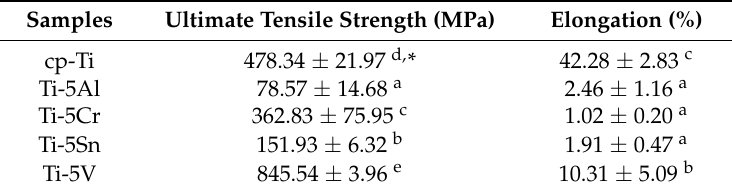
Table 3. Ultimate tensile strength and elongation values of cp-Ti and Ti alloys ( n = 3).